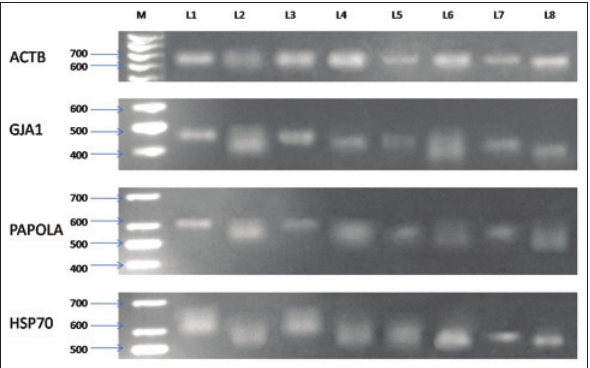
Figure-1: M=100 bp marker, L1=High competent immature (HG) stage, L2=High competent mature (HM) stage, L3=Vitrified high competent immature (VHG) stage, L4=Vitrified high competent mature (VHM) stage, L5=Low competent immature (LG) stage, L6=Low competent mature (LM) stage, L7=Vitrified low competent immature (VLG) stage, L8=Vitrified low competent mature (VLM)